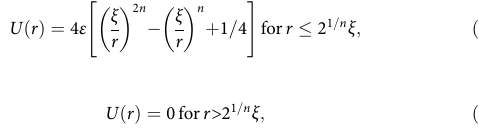
landscapes. Methods Experimental set-up . Our colloidal model system consists of silica beads of dia- meter σ = 5 μ m (Sigma aldrich, 44054) suspended in a 6% solution of hydrogen peroxide H 2 O 2 in deionized water (Millipore, 18.2M Ω ). Within a few minutes, the heavy particles sediment on the bottom wall of the sample cell to form a dense